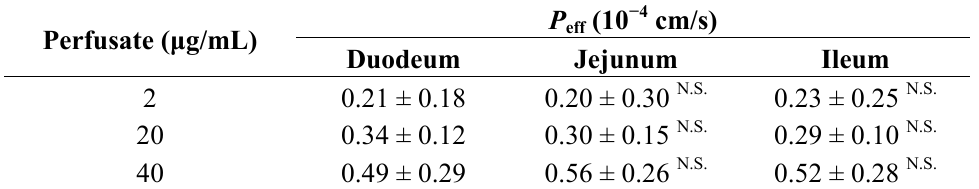
Table 5. Effective permeability of NCE using single-pass intestinal perfusion method. The data were presented as mean ± SD ( n = 6 for each group).